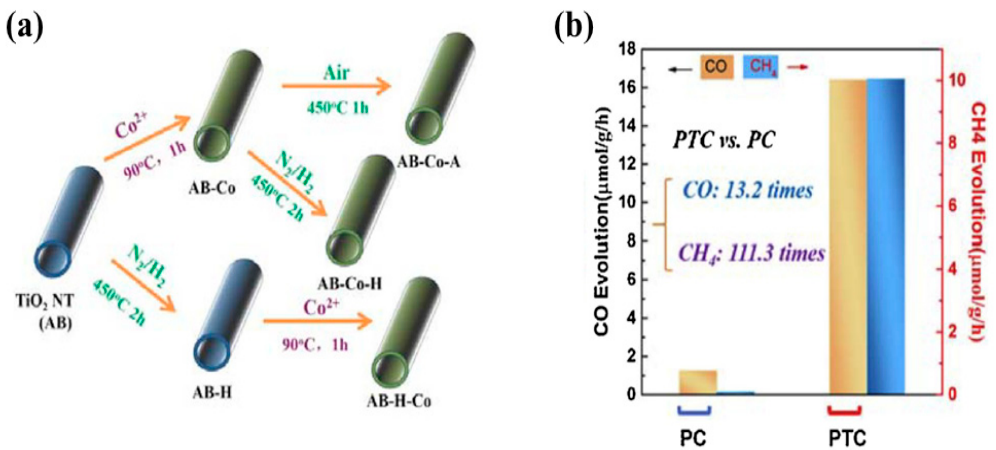
Figure 3. ( a ) Synthesis procedure for hydrogenated TiO 2 nanotubes CoOx